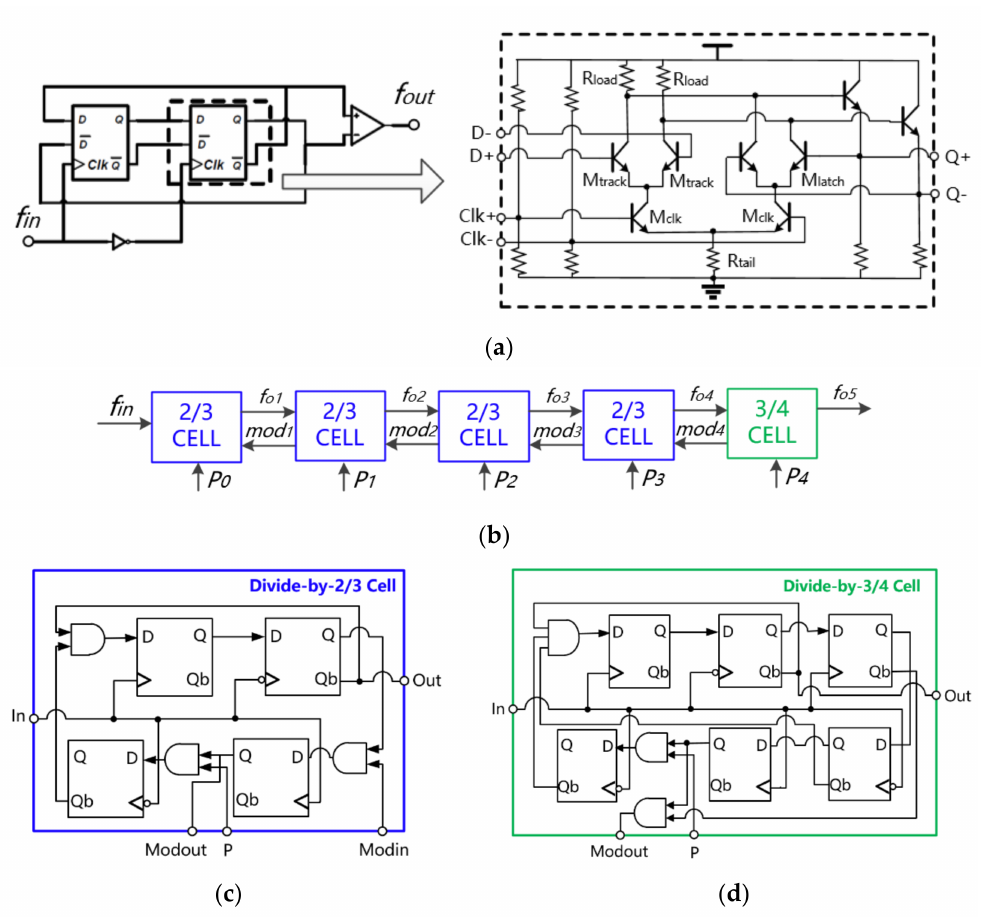
Figure 3. Schematic of the ( a ) current mode logic (CML) divide-by-2 divider and ( b ) 5-bit true